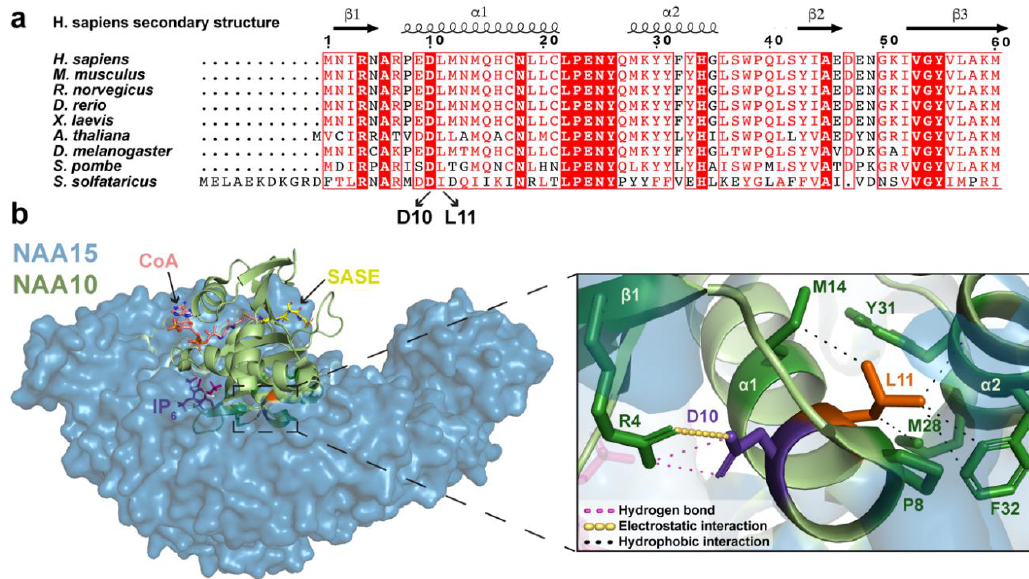
Figure 1. NAA10 multiple sequence alignment and human NatA structure. ( a ) A multiple sequence alignment of NAA10 sequences from Homo sapiens , Mus musculus , Rattus norvegicus , Danio rerio , Xenopus laevis, Arabidopsis thaliana, Drosophila melanogaster , Schizosaccharomyces pombe and Saccharolobus solfataricus . The amino acids D10 and L11 are highly conserved in the NAA10 sequences (conservation is coloured red). ( b ) NAA10 (green) and NAA15 (blue) in the human NatA structure (PDB ID: 6C9M) [21] bound with ligand IP 6 (magenta). The human NatA structure was superimposed with the substrate (SASE, yellow sticks; CoA, pink sticks) from the S. pombe NatA structure (PDB ID: 4KVM) [15]. A zoomed-in view (right) shows D10 (purple) and L11 (orange) and the interactions they form with surrounding amino acids.